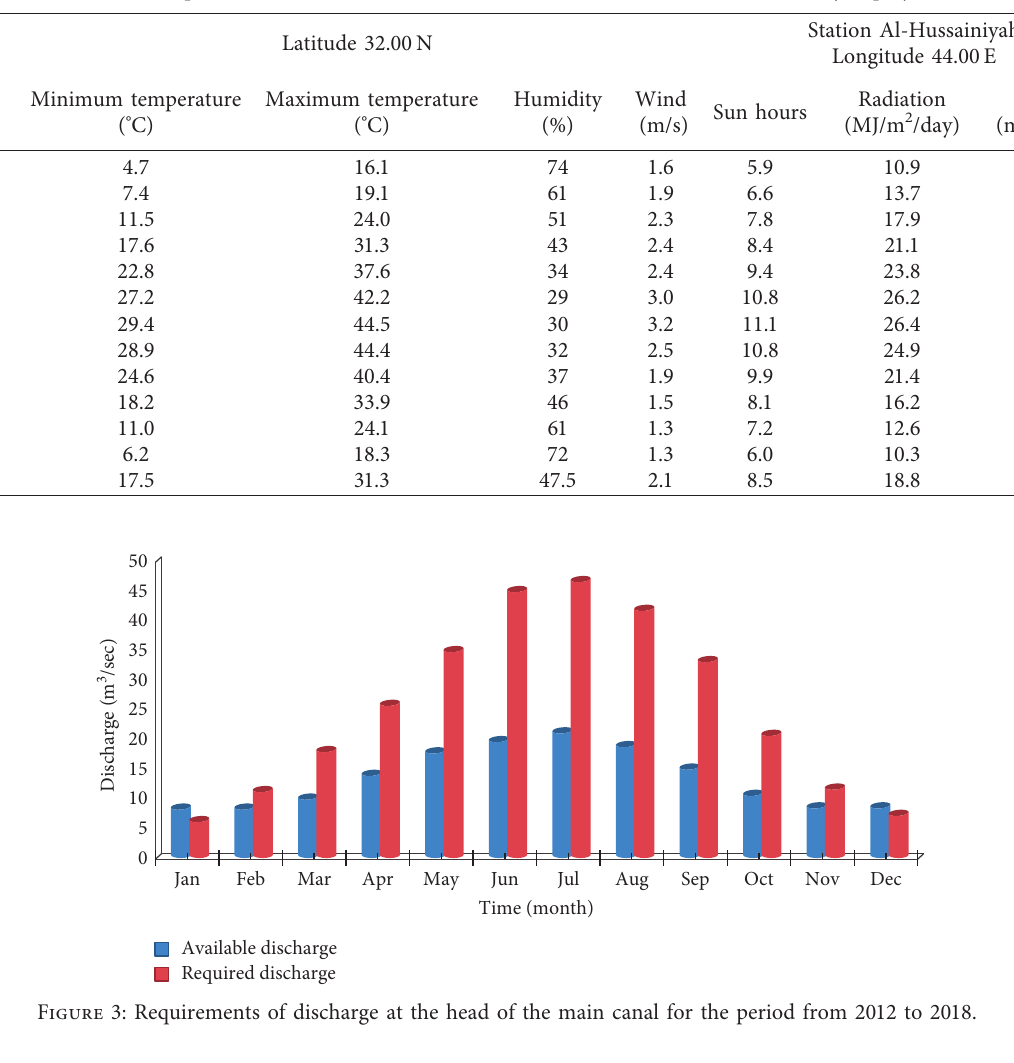
Table 7: Input climate features data and estimated results of ETo for Al-Hussainiyah project